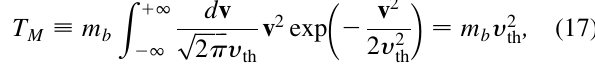
(cid:2) t (cid:3) =I comparison be- b 0